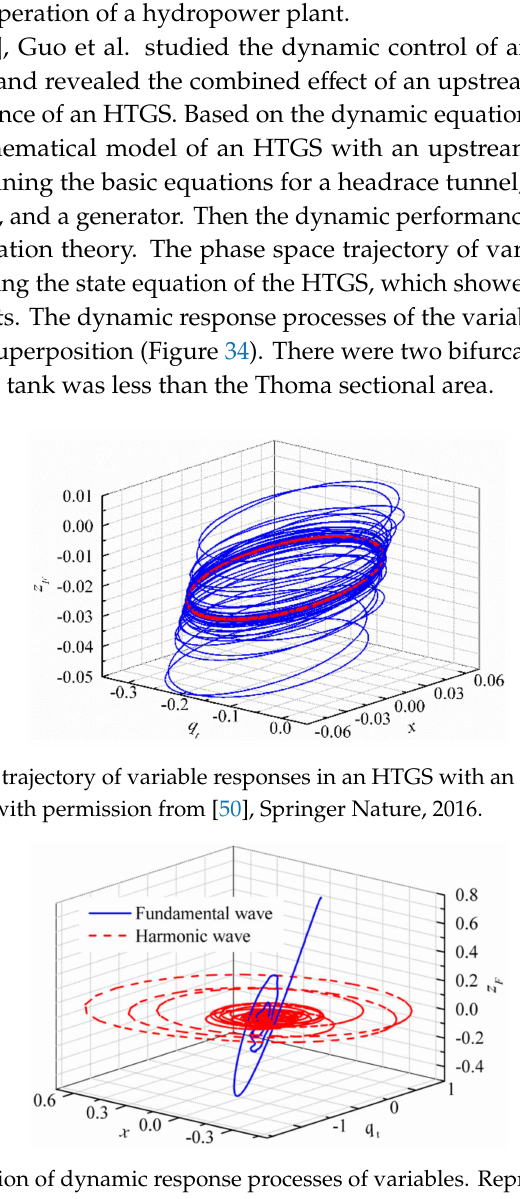
Figure 34. Decomposition of dynamic response processes of variables. Reproduced with permission from [51], Elsevier,